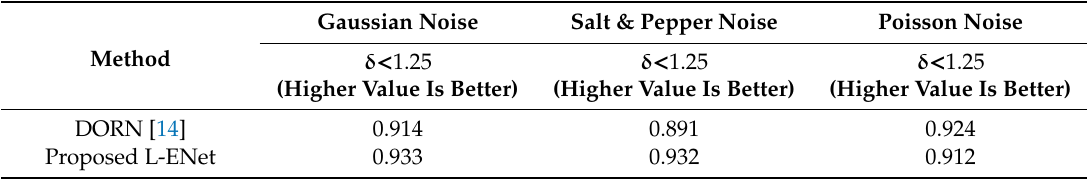
Table 3. Accuracy evaluation results on noise-added KITTI dataset.